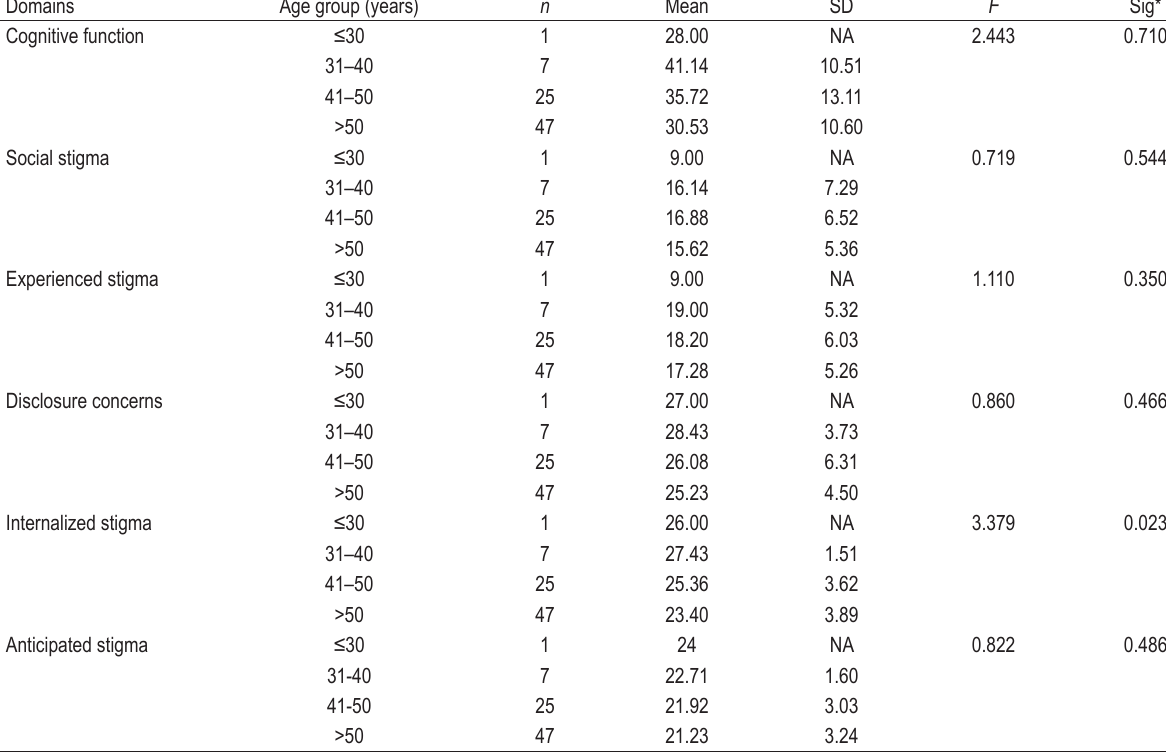
TABLE 6. Comparison of stigma mean scores between the age in six different domains Domains